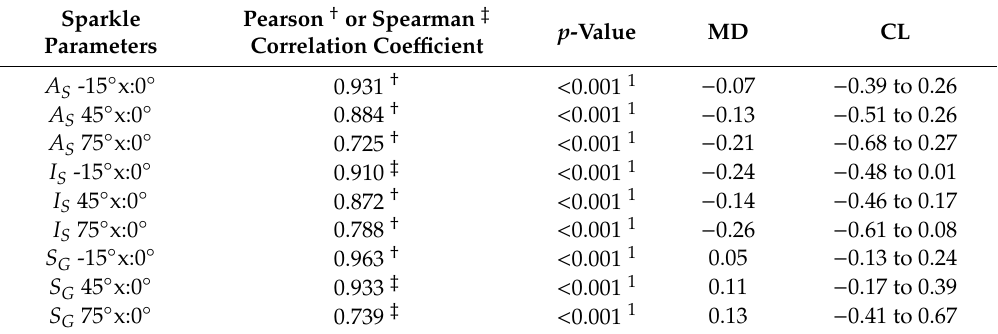
Table 1. Pearson † or Spearman ‡ correlation coe ffi cients, and corresponding p -values; and Bland and Altman analysis (mean of the di ff erences, MD, and the corresponding confidence limits, CL) between the sparkle-area ( A S ), sparkle-intensity ( I S ) and sparkle grade ( S G ) of the GOHYLED and the BYK-mac ® .